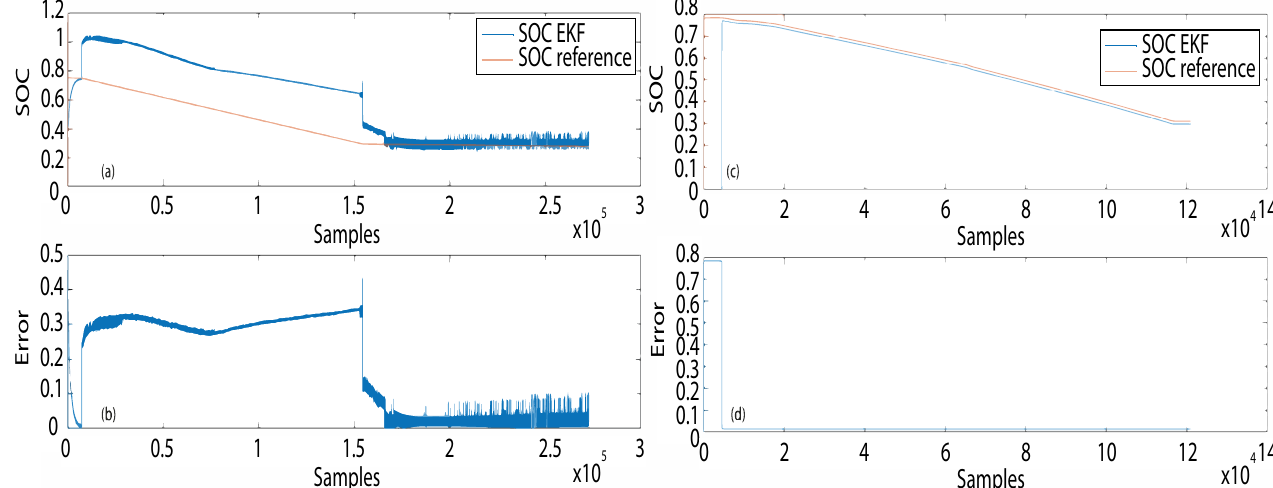
Figure 11. Results of the constant current discharge test: ( a ) SOC comparison between SOC ref and ˆ SOC with Extended Kalman Filter, and wrong parameter initialization. ( b ) The absolute error between SOC ref and ˆ SOC . ( c ) SOC comparison between SOC ref and ˆ SOC Dual Coulomb Counting Extended Kalman Filter. ( d ) The absolute error between SOC ref and ˆ SOC with